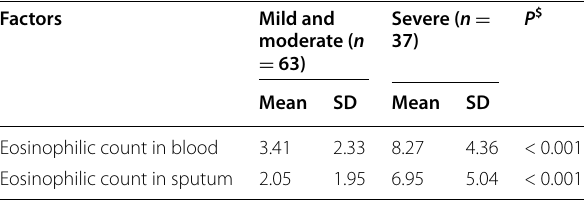
Table 3 Correlation between the “E” level in blood and sputum with exacerbation